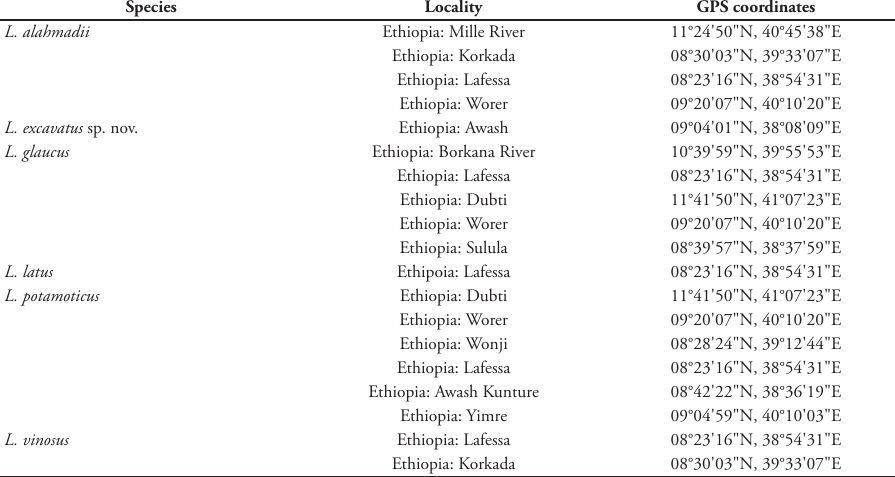
Table 2. GPS coordinates of locations of examined specimens. Species Locality GPS coordinates L.